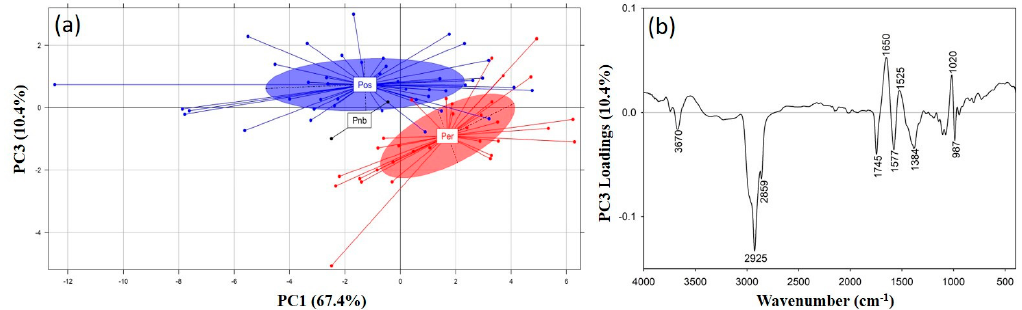
Figure 4. ( a ) Score plot of principal component analysis (PCA) (PC1 vs. PC3) for the discrimination of